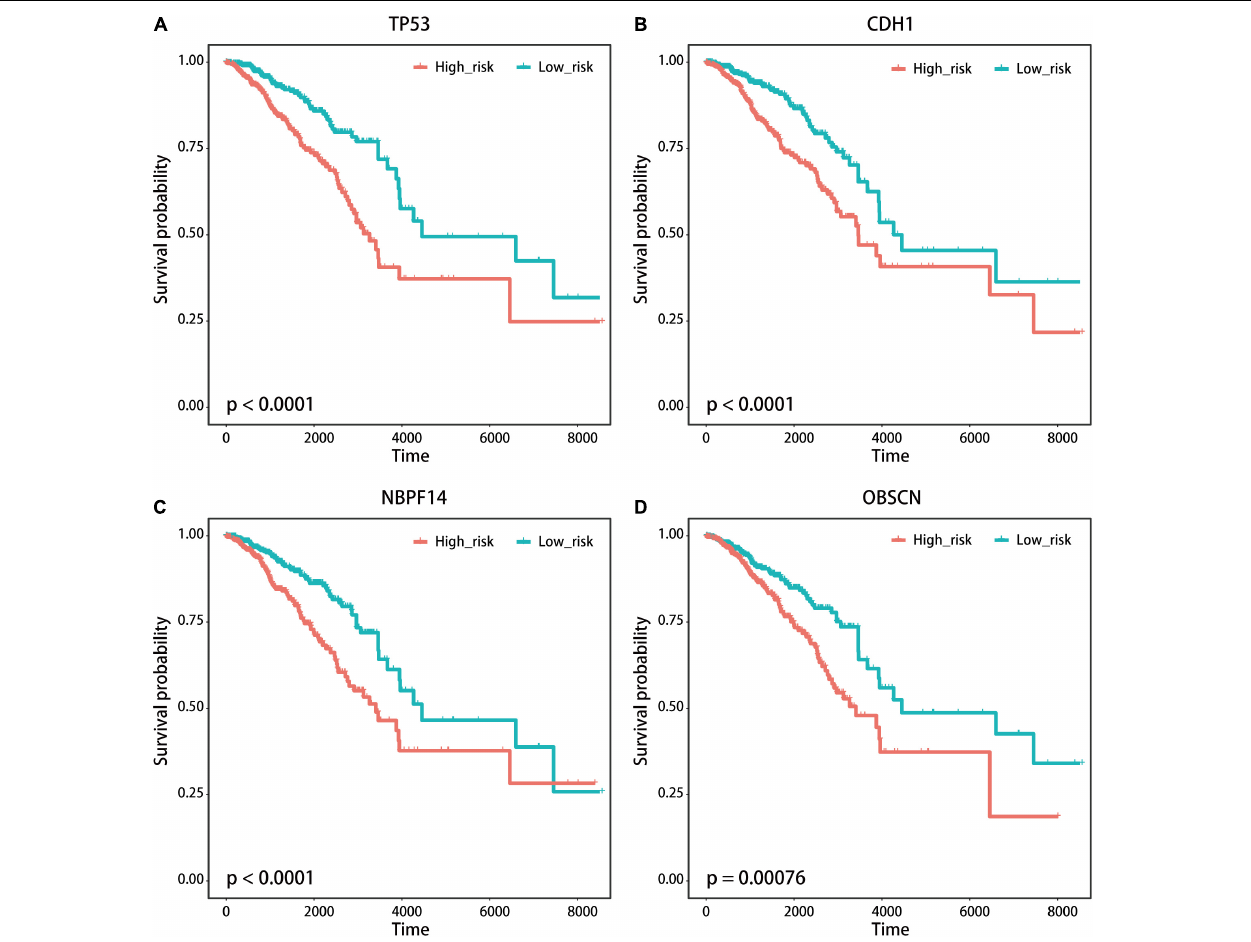
FIGURE 5 | Kaplan–Meier survival curves of patients with breast cancer classified into high- and low-risk groups based on the immune cells driven by (A) TP53, (B) CDH1, (C) NBPF14, and (D) OBSCN mutations,